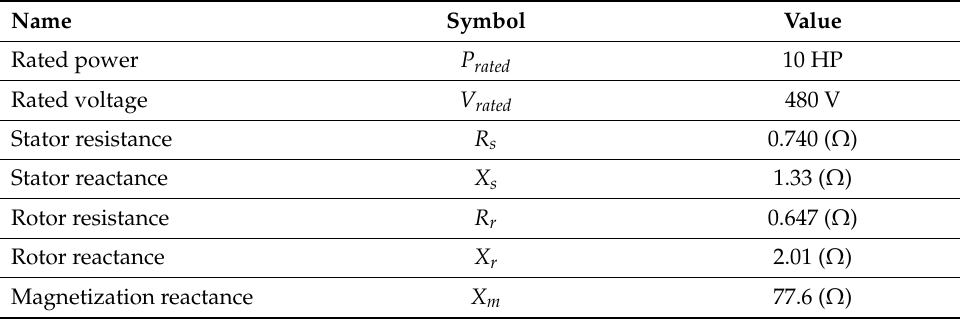
Table A7. Parameters of the asynchronous generator of the PRO power